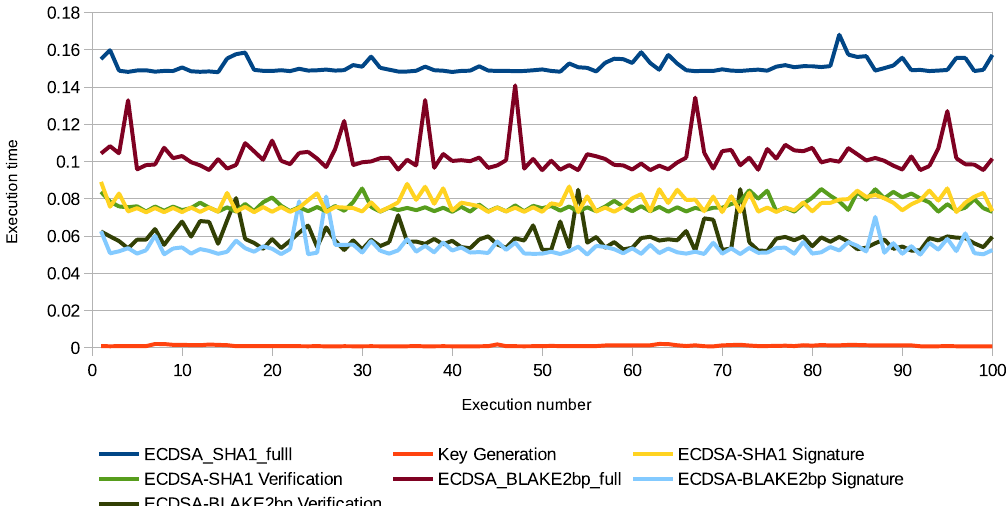
Figure 18. Execution time of ECDSA-SHA1 and ECDSA-BLAKE2bp with 1 MB data.